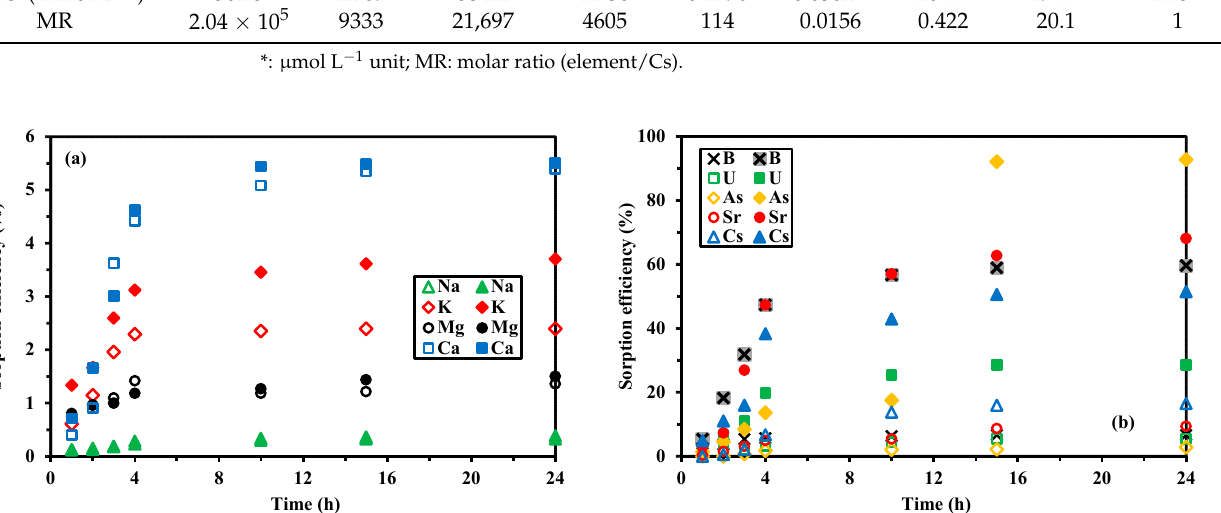
Figure A22. SEM observation (left panel) and semi-quantitative EDX analysis (right panels) of ALG- PEI ( a ) and APO-PEI ( b ) after the treatment of seawater. References 1.